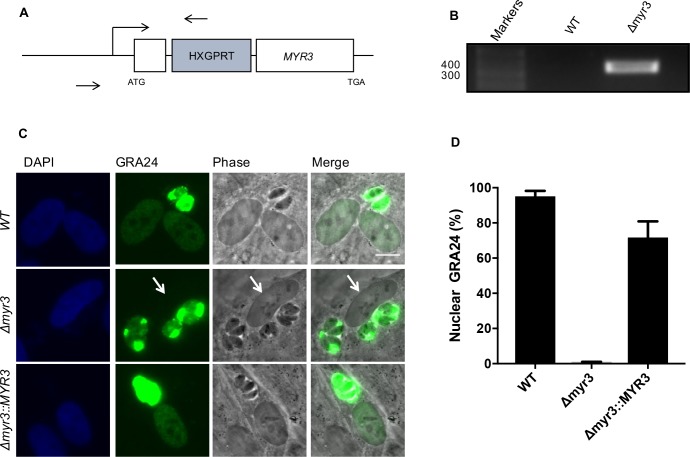
MYR3 (TGGT1_237230) is essential for effector translocation.(A) Schematic of TGGT1_237230 (MYR3) disruption. MYR3 gene disruption was performed as described in (2A), but using a sgRNA and primers specific to MYR3. (B) Disruptive integration of the HXGPRT vector in an exon of MYR3 was confirmed by PCR and sequencing. (C) Effect of MYR3 disruption and complementation on effector translocation. GRA24-Myc was transfected into WT, Δmyr3, and Δmyr3::MYR3 tachyzoites and its localization was assessed by IFA. Scale bar indicates 5 μm. White arrow indicates host nucleus lacking detectable GRA24 in the cell infected with RHΔmyr3 tachyzoites. (D) Quantitation of percentage of infected cells showing GRA24 localization in the host nucleus based on examination of at least 10 fields per each of three coverslips. Error bars reflect standard deviation for three to four replicates. Results are representative of 5 experiments.